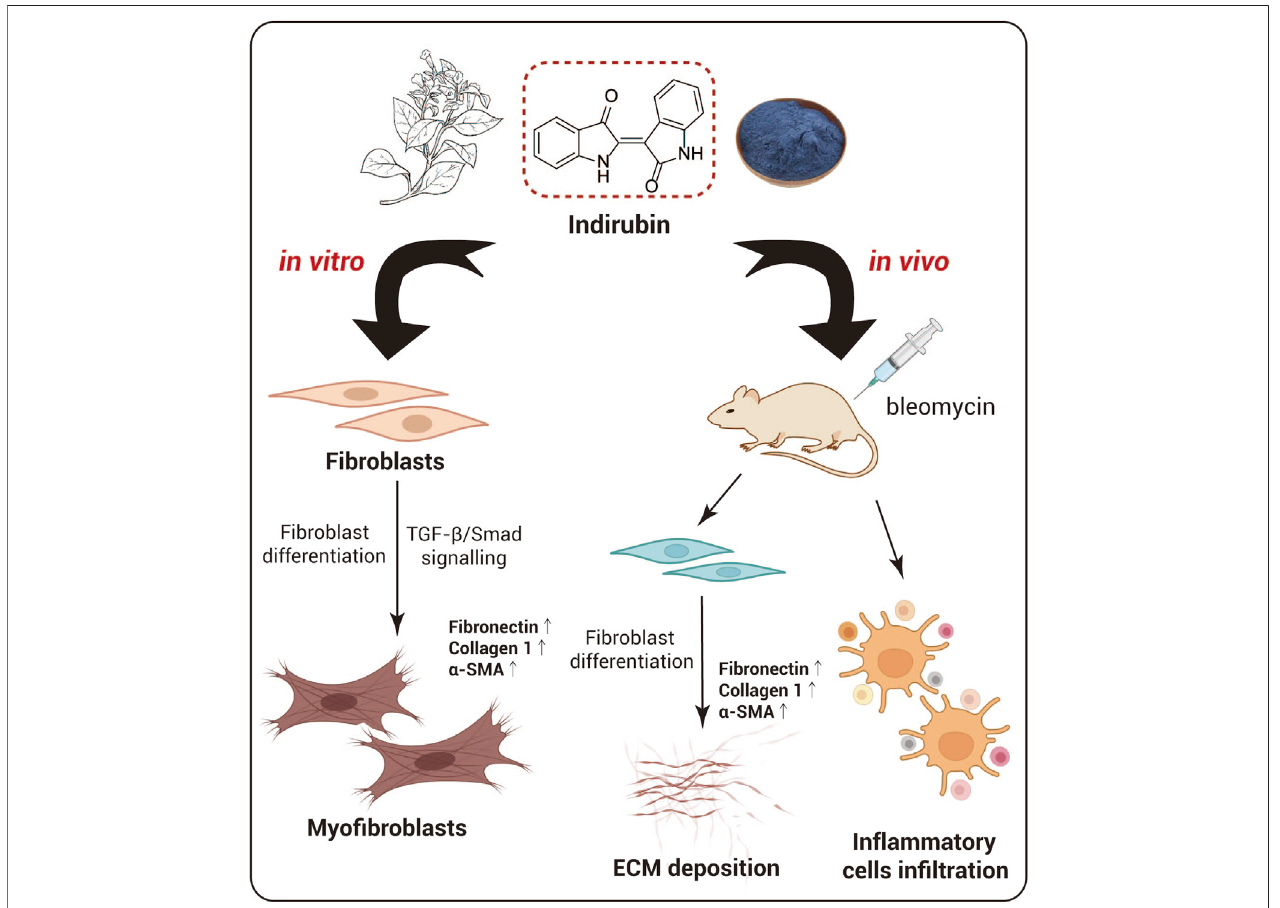
FIGURE 3 | Indirubin ameliorates bleomycin-induced pulmonary fi brosis.